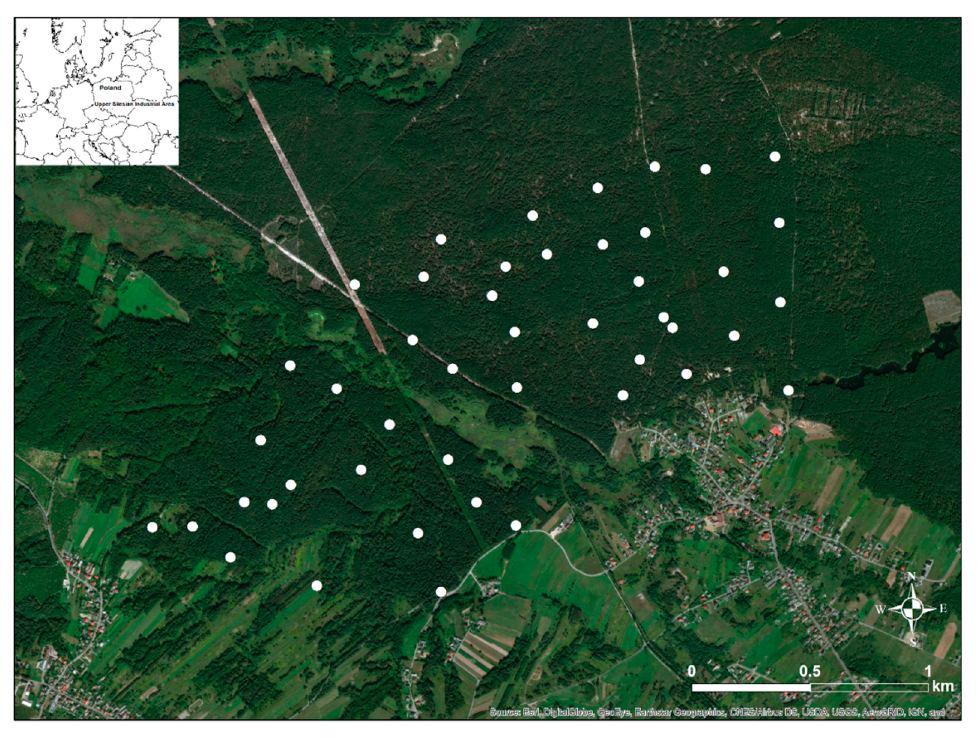
Figure 1. Location of the study area and location of sample points (marked by white dots).